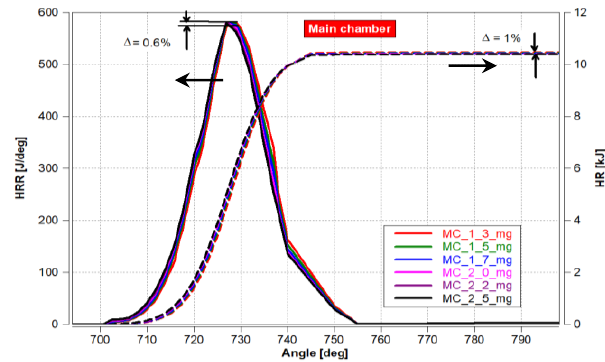
Fig. 14. HRR and HR changes in the main chamber at different fuel dose values q o_PC